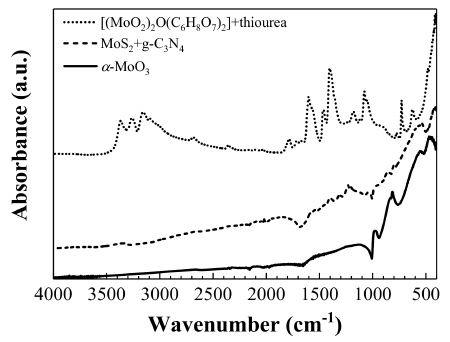
Figure 1. Normalized ATR-FTIR spectra of two intermediate steps of the synthesis and the final α -MoO 3 product. An offset has been added for clarity purposes.